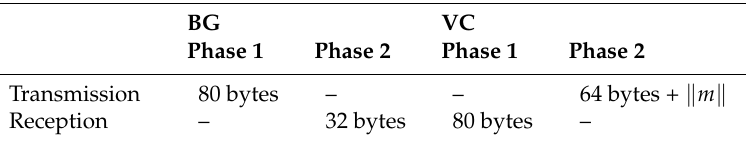
Table 3. Communication length at the BG and VC.